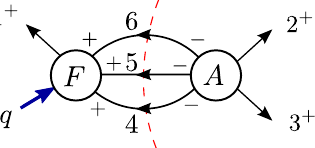
Figure 8 . Triple cut of the two-loop form factor in the s 23 -channel with only gluons running in the loop involving an MHV